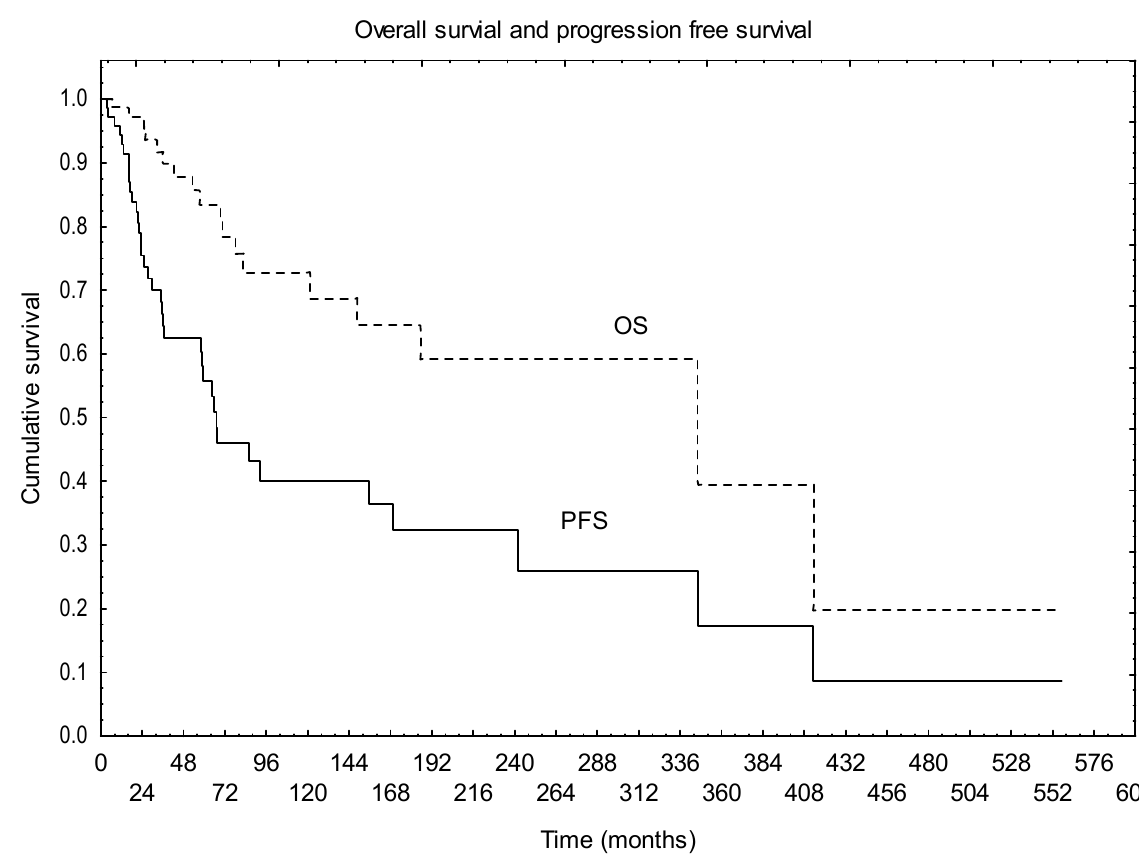
Figure 1. Overall survival and progression free survival of the whole group. Factors that were found to have statistically significant negative impact on OS in univariate analysis are the presence of metastases at diagnosis ( p = 0.003), grade III subtype ( p = 0.042) and worse performance status ( p = 0.023). Patients after R0 resection tended to have better OS, although the difference was not statistically significant in the univariate analysis ( p = 0.068). Multivariate analysis confirmed that the presence of metastases was the only factor independently affecting OS ( p = 0.0001). Other analysed factors (age, tumour location, primary treatment applied or the sequence of adjuvant treatment, factors related to RTH, disease symptoms) were not found to influence OS.